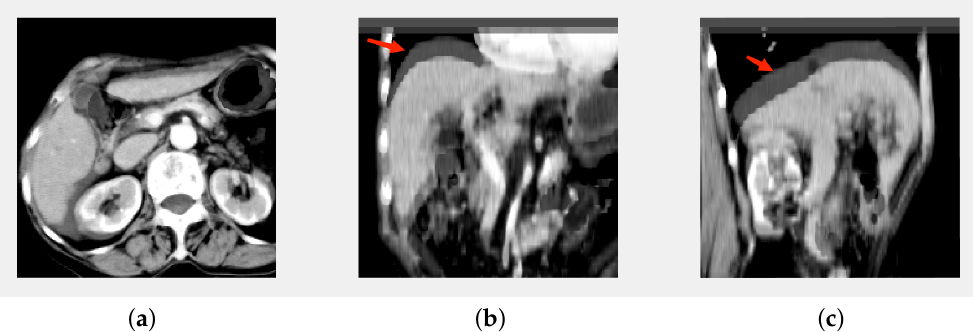
Figure 10. Illustration of sliding and deformation by superimposing the PV image onto the AP in axial ( a ); frontal ( b ); and sagittal view ( c );